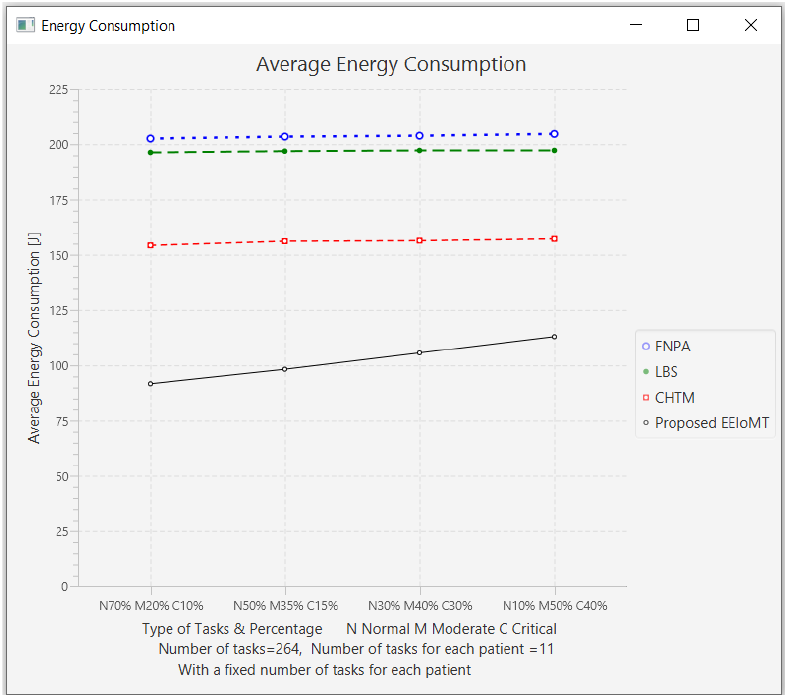
Figure 25. Average energy consumption comparison when changing the percentage of each type of task.